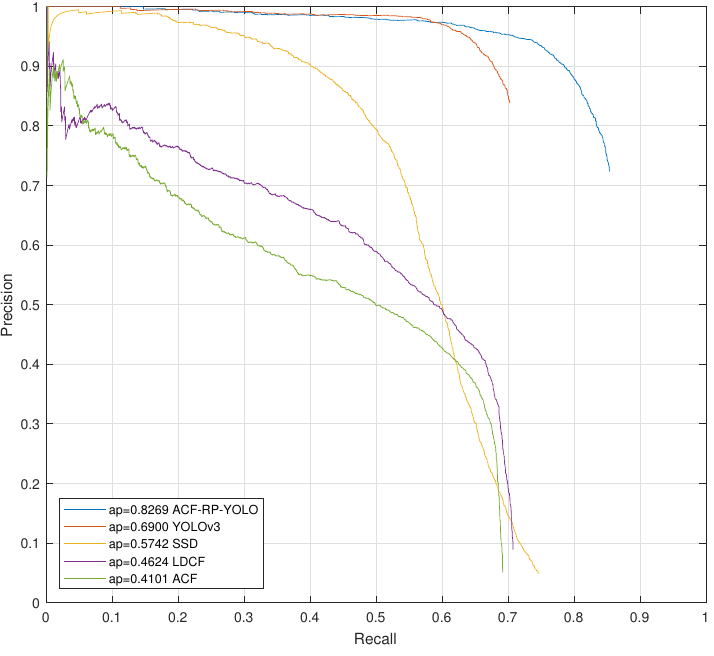
Figure 7. Precision versus recall curves of various detectors with different settings in Tsinghua-Daimler Cyclist Dataset. The average precision (AP) is listed before the name of each method. ACF-PR-YOLO is the proposed method.